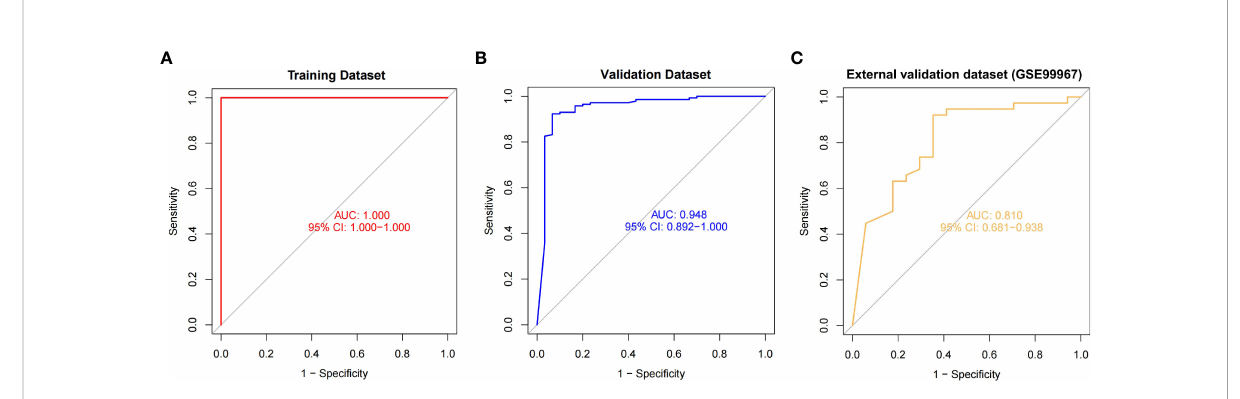
FIGURE 6 The ROC curves and their respective AUC values were used to evaluate the performance of the random forest model on the training (A) , validation (B) and external validation (C)